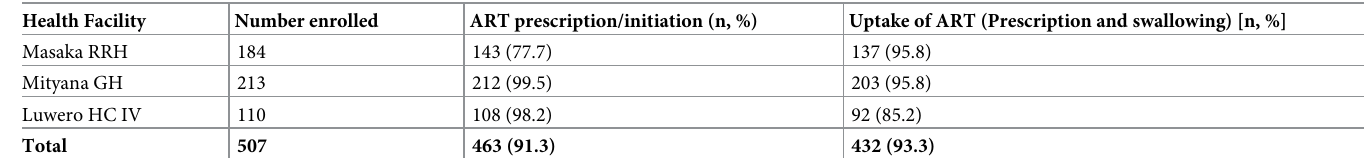
Table 5. Enrolment into the study (N = 507), ART prescription (n = 463) and uptake of Option B+ (n = 432) by health facility.